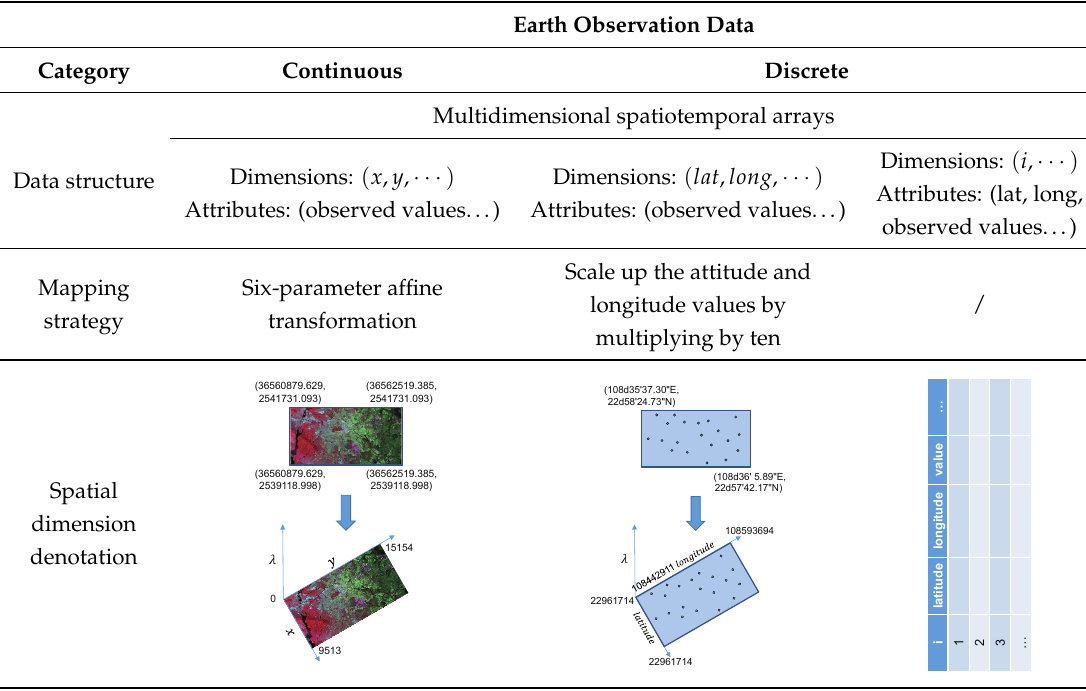
Table 1. EO data organization in array database.